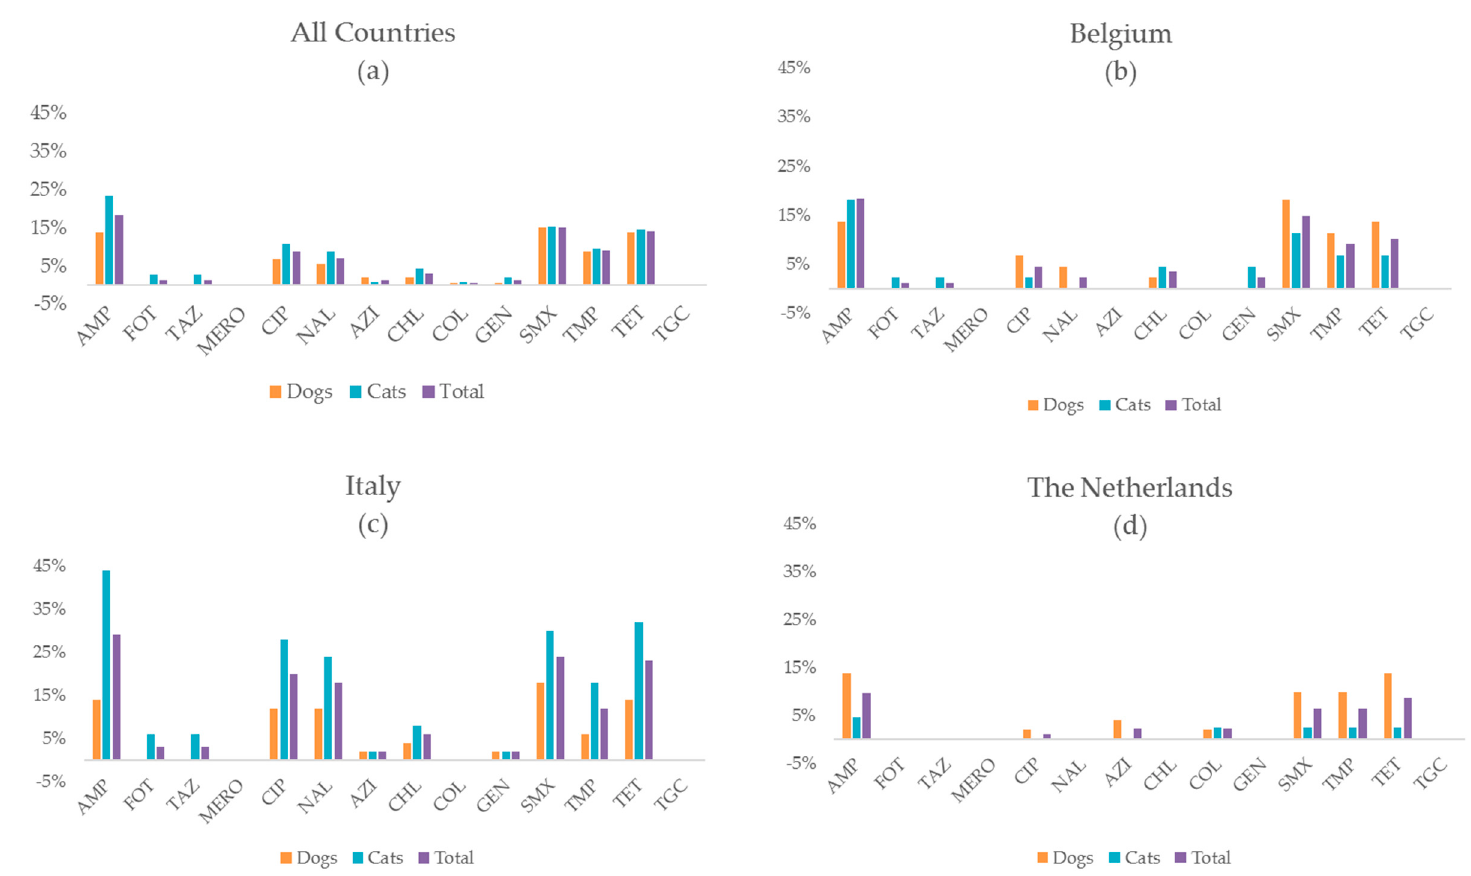
Figure 2. Antimicrobial resistance proportions (%) among Escherichia coli isolates from feces of dogs and cats in three European countries against a set of 14 antimicrobials. ( a ) Shown for all samples with a successful E. coli isolations from cats ( n = 137) and dogs ( n = 148); ( b ) E. coli from Belgian cats ( n = 44) and dogs ( n = 44); ( c ) E. coli from Italian cats ( n = 50) and dogs ( n = 50); ( d ) E. coli from Dutch cats ( n = 43) and dogs ( n = 51). AMP = ampicillin; FOT = cefotaxime; TAZ = ceftazidime; MERO = Meropenem; CIP = ciprofloxacin; NAL = nalidixic acid; AZI = azithromycin; CHL = chloramphenicol; COL = colistin; GEN = gentamicin; SMX = sulfamethoxazole; TMP = trimethoprim; TET = tetracycline; TGC = tigecycline. (Table S4).